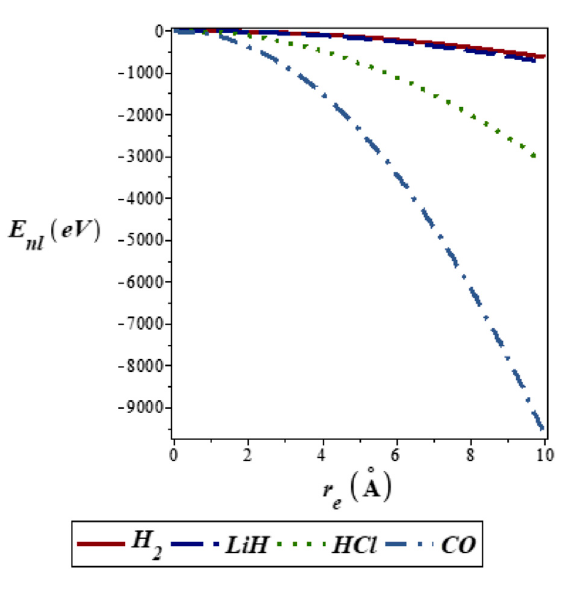
FIGURE 2 Variation of energy eigenvalues of the SSKP with equilibrium bond length for different diatomic molecule systems with n = 2 and l =